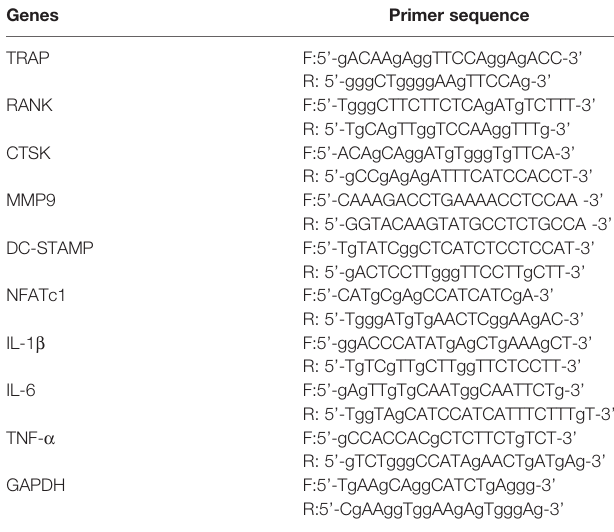
TABLE 1 | Primer sequence for Quantitative Real-Time PCR.